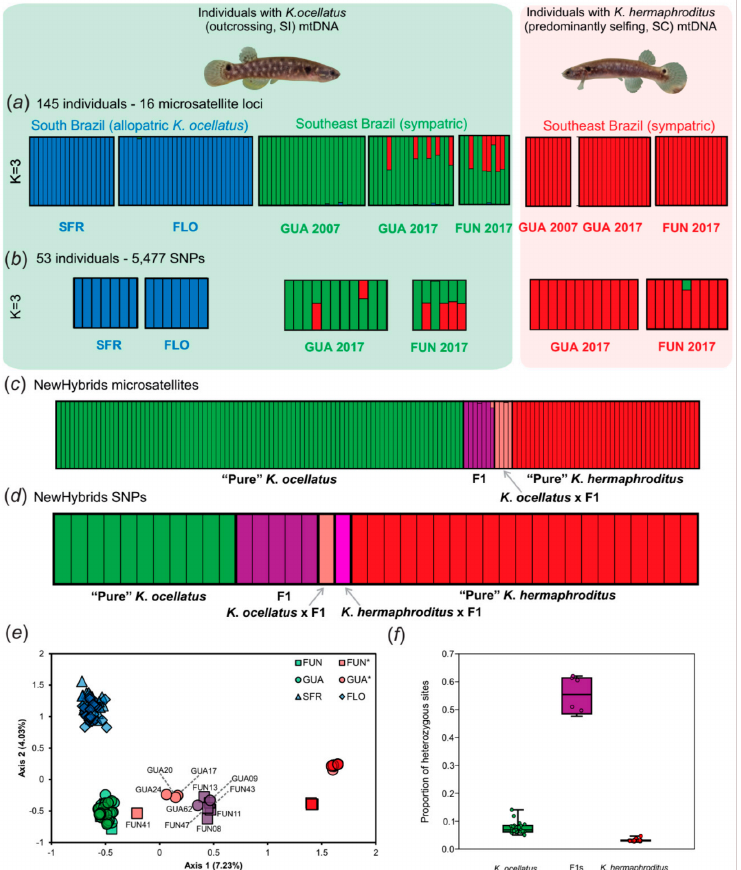
Figure 3. Genetic analyses for the hybrid zone between Kryptolebias ocellatus and K . hermaphroditus in Southeast Brazil. Admixture plots showing the genetic clusters (K = 3) for the ( a ) 16 microsatellites loci amplified in K. ocellatus and K . hermaphroditus according to STRUCTURE and ( b ) for the 5477 SNPs according to ngsAdmix (see Methods for details). Each individual is represented by a bar, and each color represents a genetic cluster. ( c , d ) NEWHYBRIDS individual classification into hybrid classes ( K . ocellatus , K . hermaphroditus , F1, F2, K . ocellatus × F1 and K . hermaphroditus × F1) using microsatellite and SNPs data. ( e ) Factorial correspondence analysis using microsatellites data for all K . ocellatus and K . hermaphroditus individuals colored (green and blue for K. ocellatus from Southeast and South Brazil, respectively; red for K. hermaphroditus ) and shaped according to sampling sites (squares, circles, triangles, and diamonds represent individuals from FUN, GUA, SFR and FLO, respectively). Hybrid individuals (see Results) are highlighted with their respective labels and colored (purple for F1s, pink for backcrosses) according to the hybrid class indicated by NEWHYBRIDS analysis. Sampling locations with asterisks represent K . hermaphroditus individuals. ( f ) Proportion of heterozygous sites between K . ocellatus , K . hermaphroditus and F1 hybrid